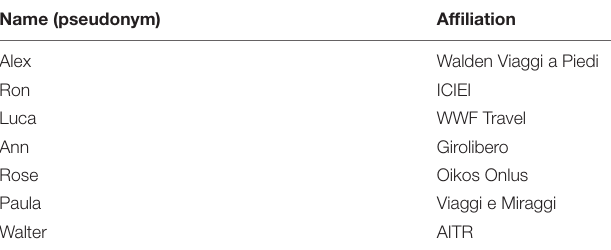
TABLE 2 | List of tour